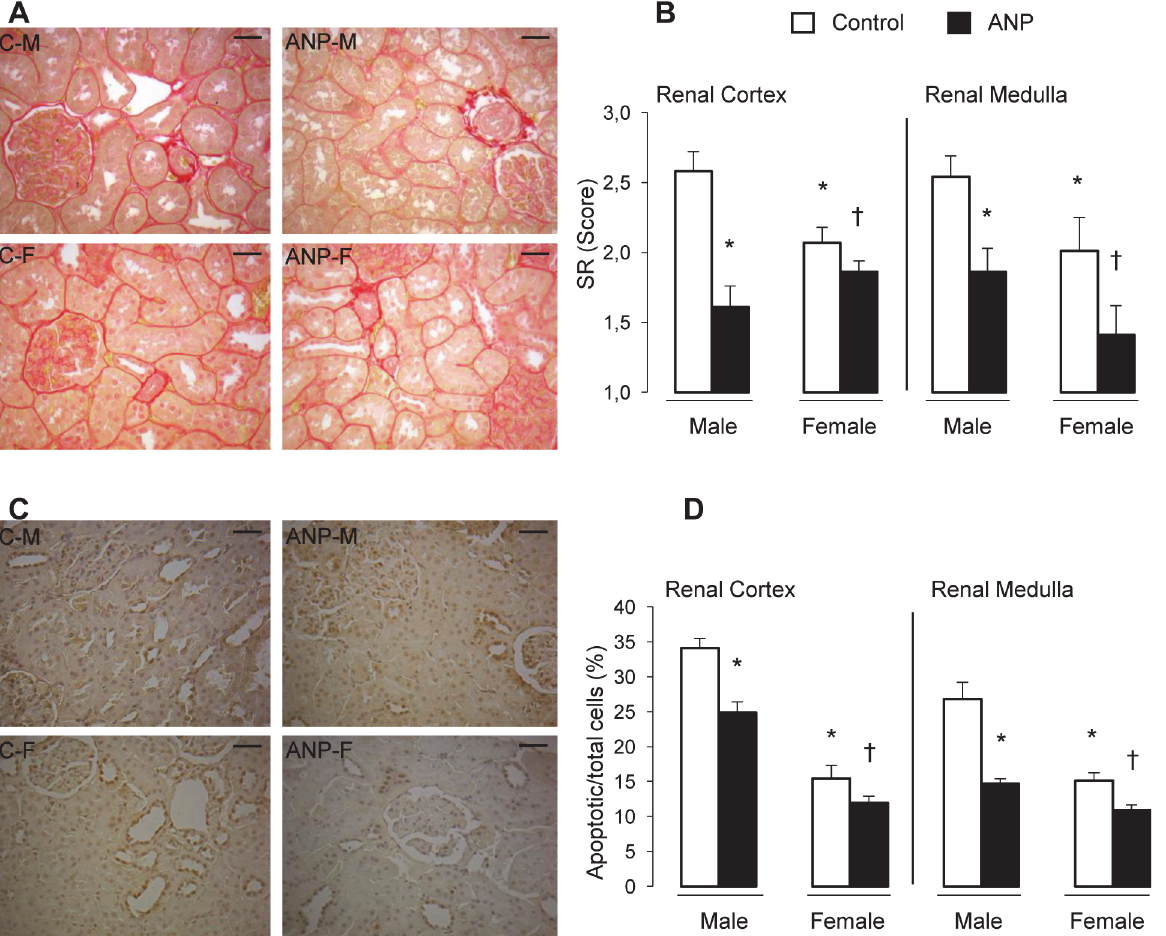
Fig 3. Sirius Red staining and TUNEL positive apoptotic nuclei in kidney after treatment with ANP. (A) The red colour of Sirius red staining under the light microscope indicates total collagen deposits, representative images are from renal cortex of each group; (B) Sirius red Score values; (C) Representative micrographs of TUNEL staining in renal cortex and medulla; (D) Apoptotic cells quantification. C-M: Control male; ANP-M: ANP male; C-F: Control female; ANP-F: ANP female. All images are at the same magnification (400X). Scale bar: 30 μ m. Value represents mean ± SEM (n = 12) * p < 0.01 vs Control male, † p < 0.01 vs Control